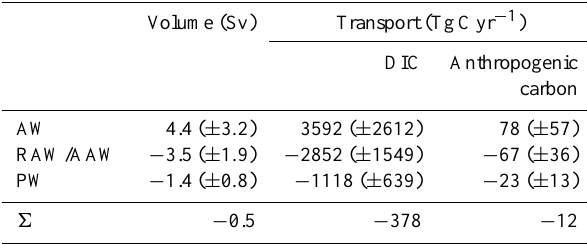
Table 2. Flux estimates of DIC and anthropogenic carbon in the Fram Strait in 2012. Positive values describe poleward fluxes into the Arctic